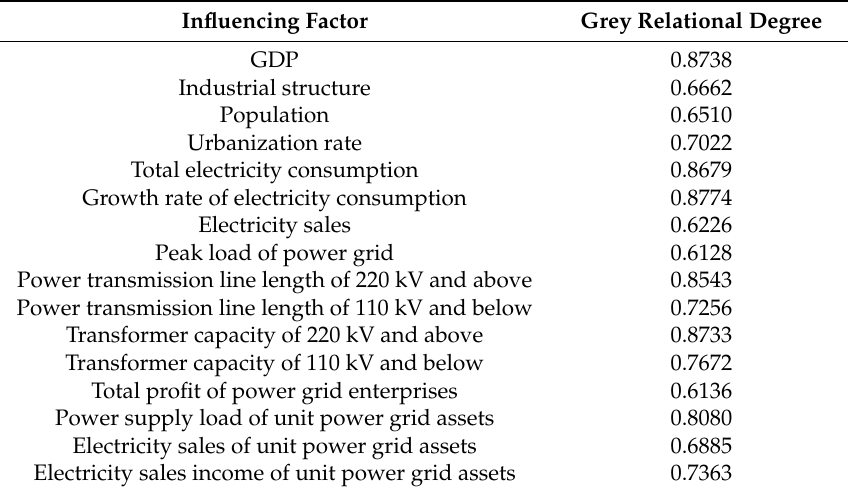
Table 1. The calculation results of the grey relational degrees for influencing